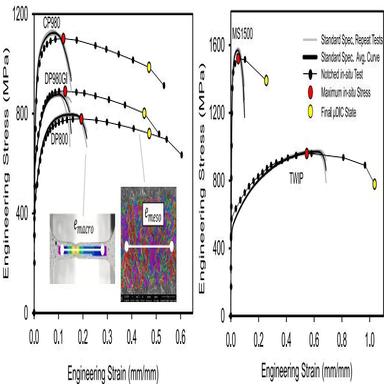
The engineering stress-strain results for Standard and Notched specimen tests. The Notched specimen in-situ data points represent SEM images from the in-situ tests. The yellow data point represents the final micrograph used in the μDIC analysis. (For interpretation of the references to colour in this figure legend, the reader is referred to the web version of this article.)